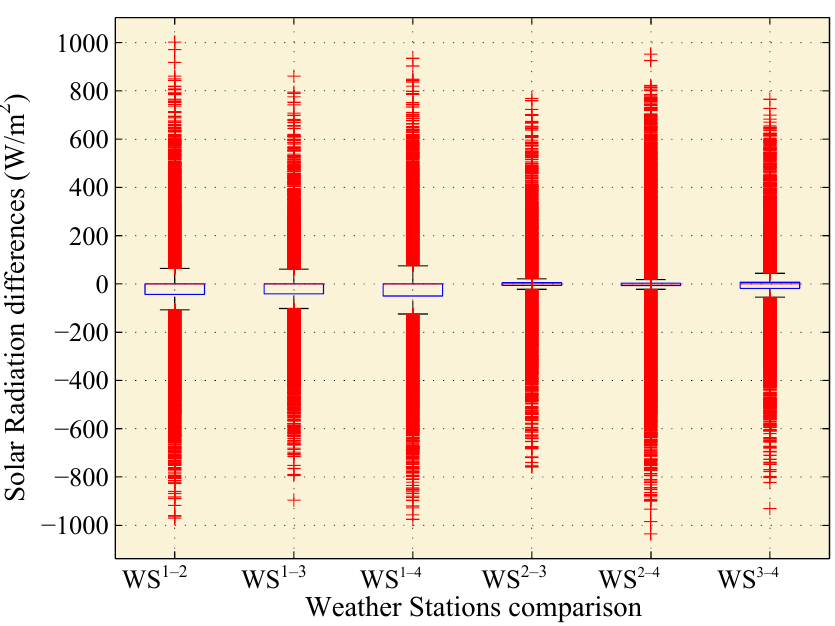
Figure 9. Box plots of solar radiation differences between weather stations.